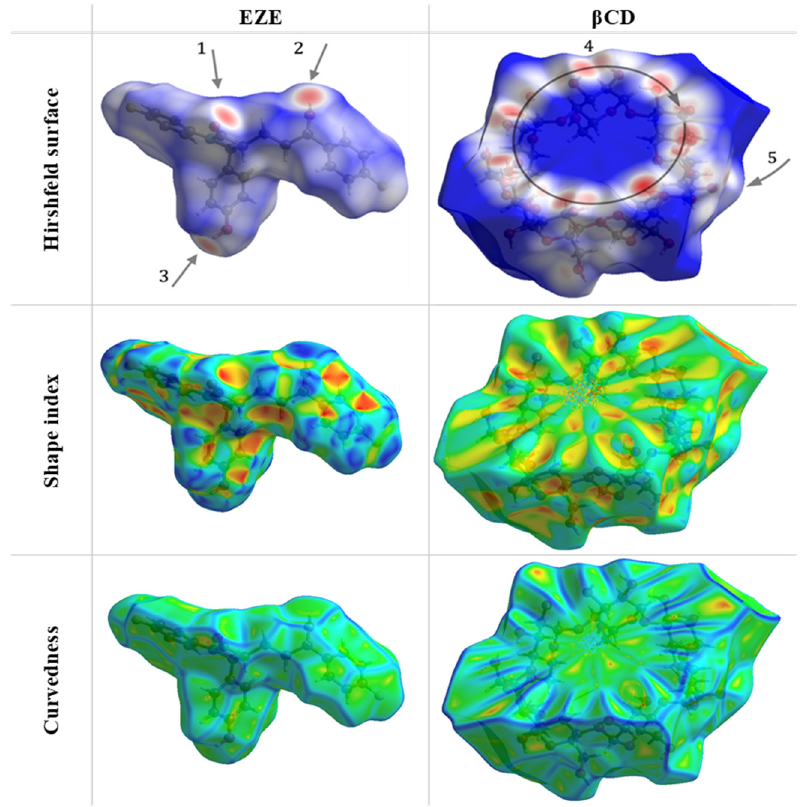
Figure 10. Hirshfeld surfaces mapped with d norm , shape index, and curves for ezetimibe and β CD. For the ezetimibe Hirshfeld surface, the water molecule was omitted for clarity. Arrows 1–5 indicate potential regions for hydrogen bonding.